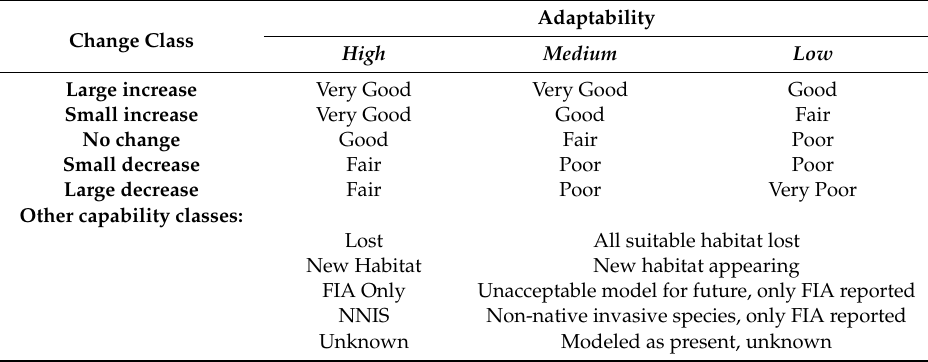
Table 1. Initial capability class ratings defined as colored classes, depending on the change class and adaptability of the species, and other classes for selected species. For final capability rating (Very Good to Very Poor): if abundance was ‘Abundant’, move up one class; if ‘Rare’ move down one class; if ‘Common’ stay in